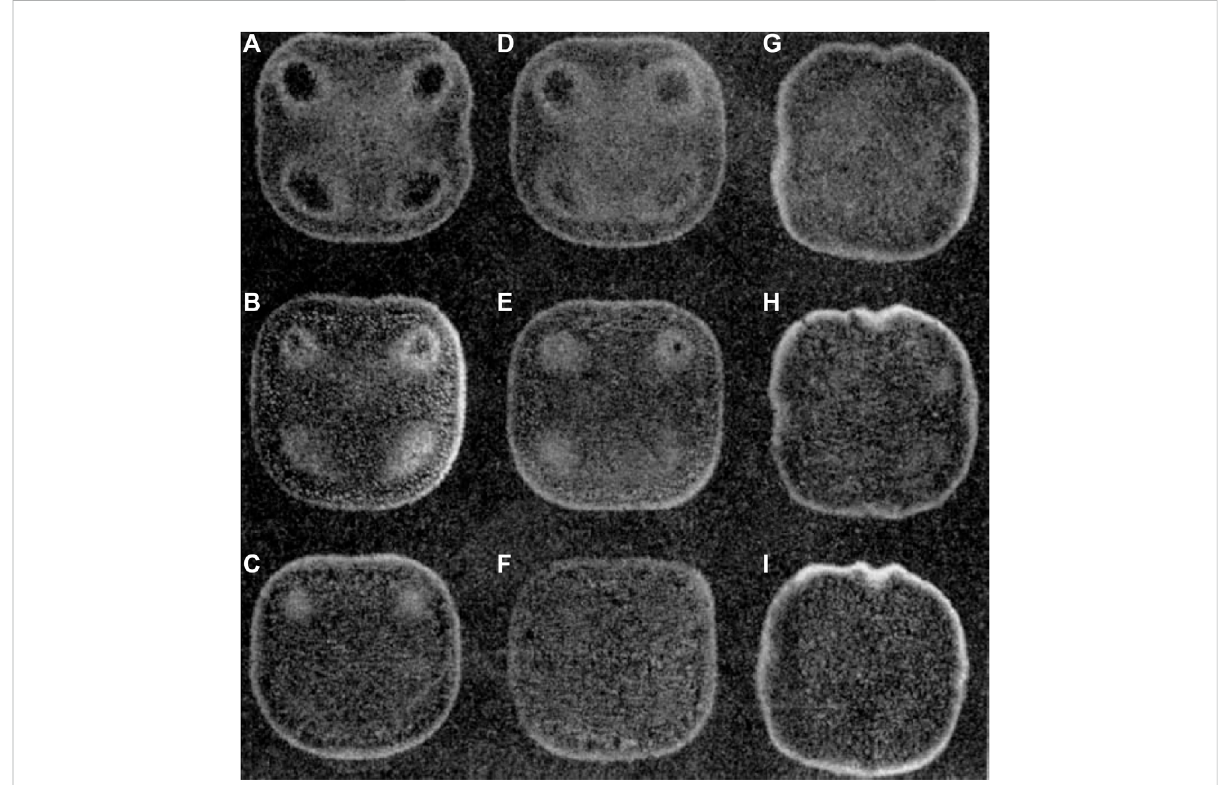
FIGURE 14 Surface appearance of copper specimens after vibratory cavitation erosion in: (A) , distilled water for 10 min; (B) , distilled water for 20 min; (C) , distilled water for 60 min; (D) , equilibrated 100 w. p.p.m. polyacrylamide solution for 10 min; (E) , equilibrated 100 w. p.p.m. polyacrylamide solution for 20 min; (F) , equilibrated 100 w. p.p.m. polyacrylamide solution for 60 min; (G) , equilibrated 1000 w. p.p.m. polyacrylamide solution for 10 min; (H) , equilibrated 1,000 w. p.p.m. polyacrylamide solution for 20 min; (I) , equilibrated 1,000 w. p.p.m. polyacrylamide solution for 60 min (Ashworth and Procter, 1975). Magni fi cation